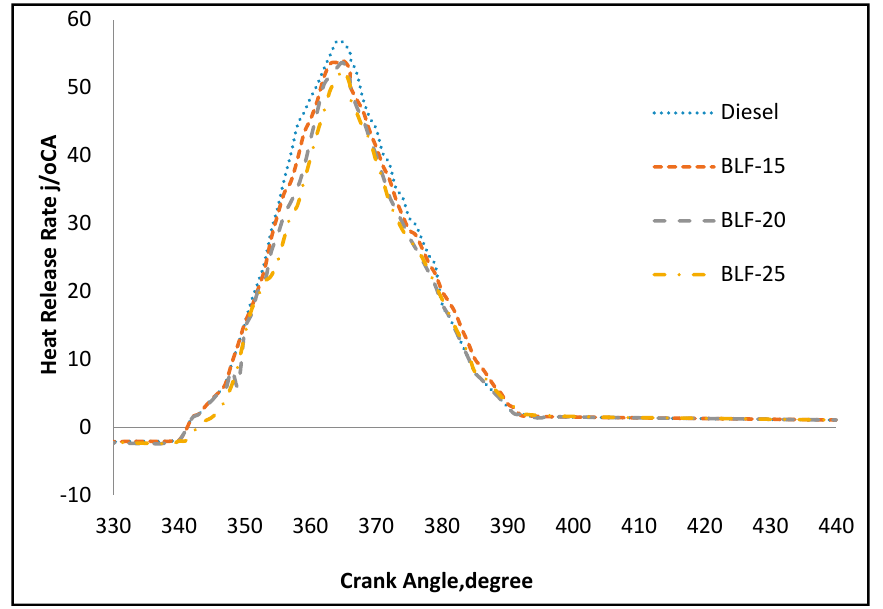
Figure 5. Variations of heat release rate vs. crank angle, in degrees at maximum engine load.